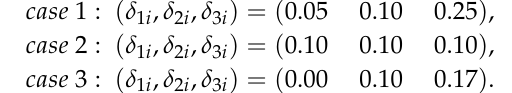
Table 6. Effect of uncertain information on optimal